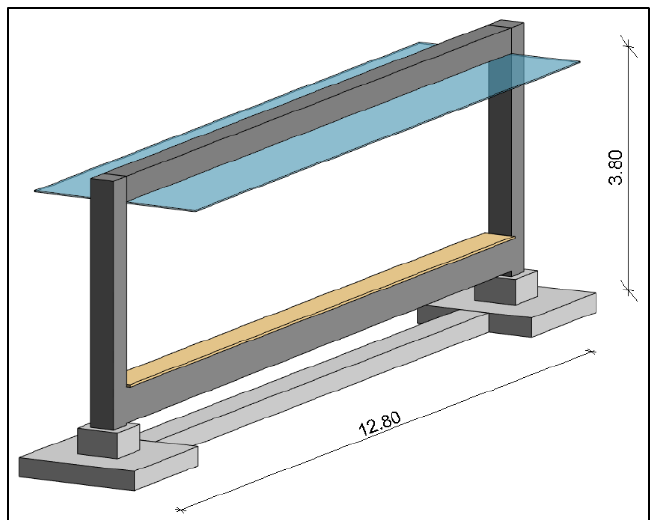
Figure 8. Shelter geometry by Revit.